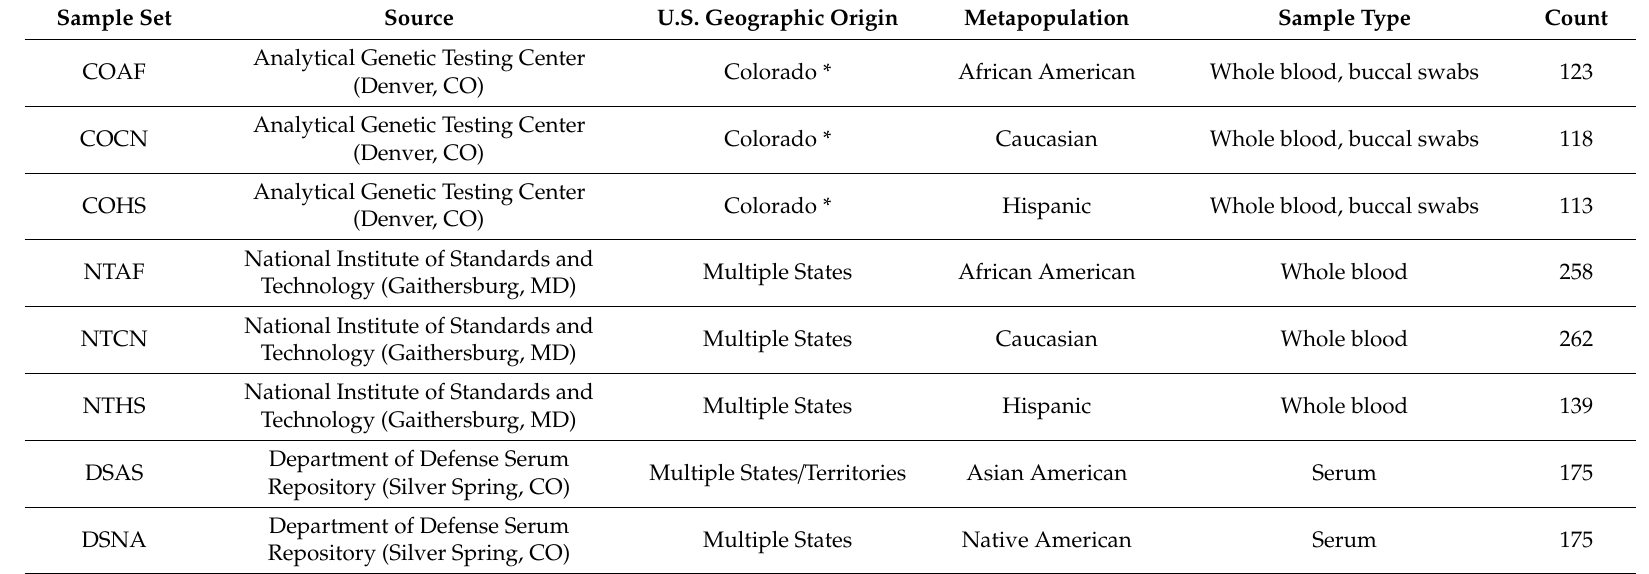
Table 1. Sample set information for all 1363